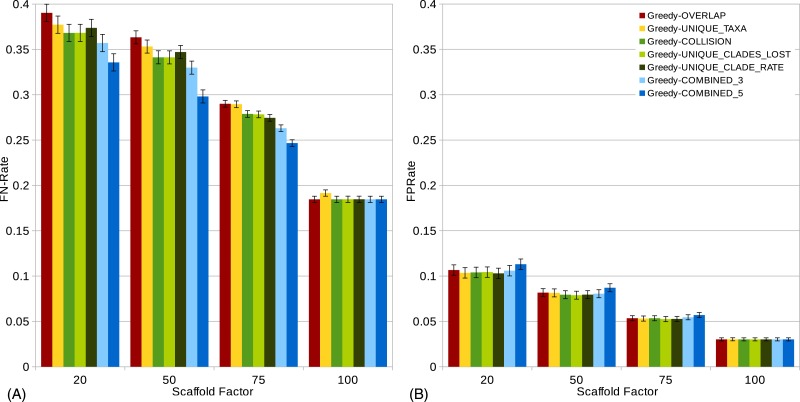
\documentclass[12pt]{minimal}
\usepackage{amsmath}
\usepackage{wasysym}
\usepackage{amsfonts}
\usepackage{amssymb}
\usepackage{amsbsy}
\usepackage{upgreek}
\usepackage{mathrsfs}
\setlength{\oddsidemargin}{-69pt}
\begin{document}
}{}$\mathit{FN}$\end{document}FN-rates (A) and \documentclass[12pt]{minimal}
\usepackage{amsmath}
\usepackage{wasysym}
\usepackage{amsfonts}
\usepackage{amssymb}
\usepackage{amsbsy}
\usepackage{upgreek}
\usepackage{mathrsfs}
\setlength{\oddsidemargin}{-69pt}
\begin{document}
}{}$\mathit{FP}$\end{document}FP-rates (B) of single scorings functions (Overlap, Unique-Taxa, Collision, Unique-Clades-Lost, Unique-Clade-Rate) and their combinations (Combined-3,Combined-5) for all scaffold factors (20%, 50%, 75%, 100%) of the 1,000-taxon dataset.The Combined scorings are the semi-strict consensus of the supertrees calculated by the respective scoring functions. The error bars show the standard error.